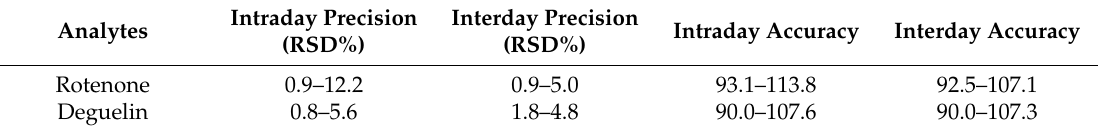
Table 2. Intraday and interday precisions and accuracies data.